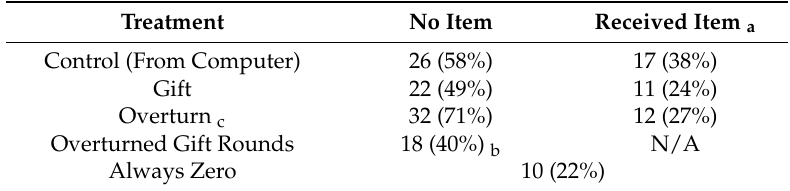
Table 3. Number of Dictators Allocating $0 by Item and